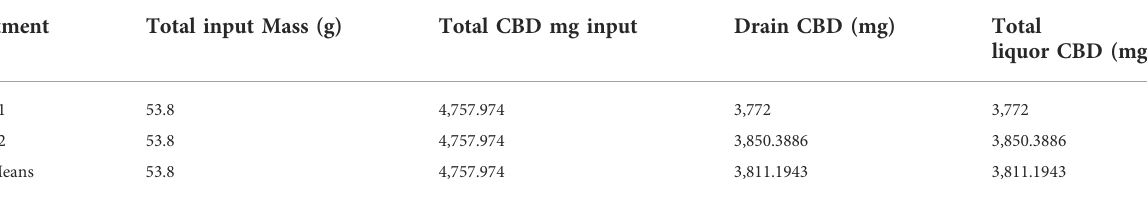
TABLE 2 CBD recovery by